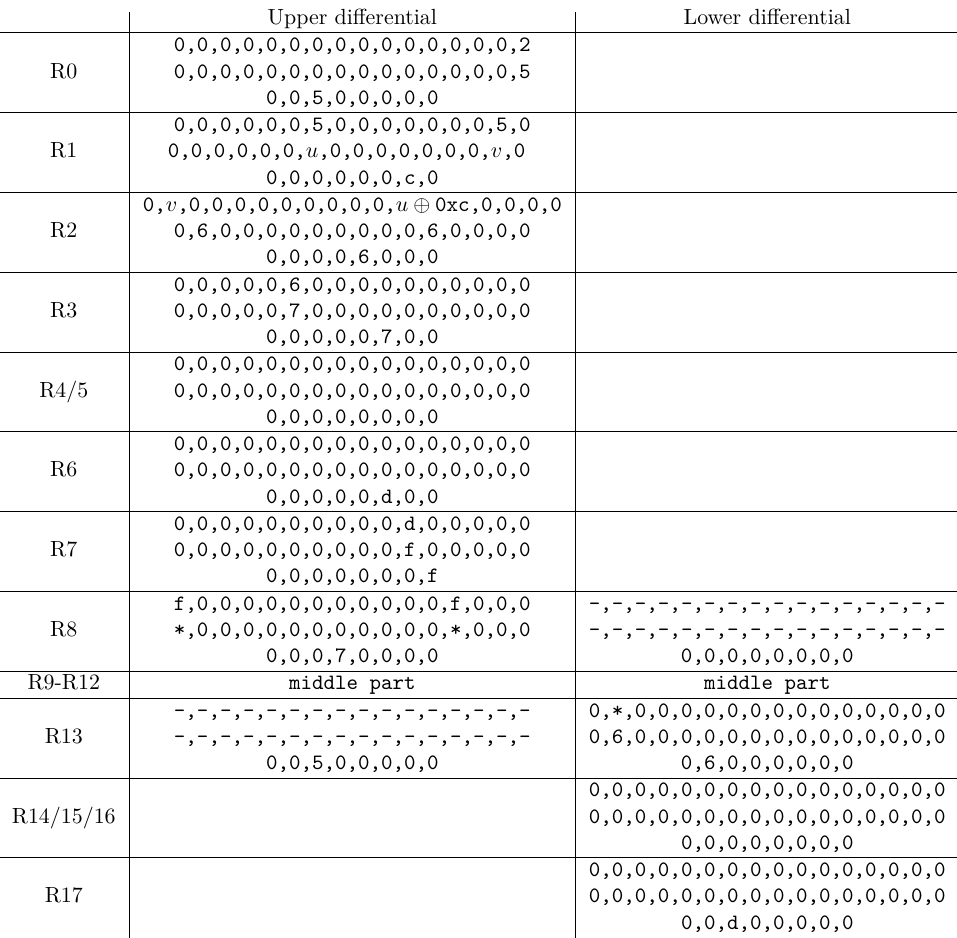
Table 16: The differentials of the 18-round distinguisher for Skinny-64-128 , where R8 to R13 is the r = 6-round middle part, u satisfies DDT[ 0x5 ][ u ] > 0 and DDT[ u ⊕ 0xc ][ 0x6 ] > m 0, v satisfies DDT[ 0x5 ][ v ] > 0 and DDT[ v ][ 0x6 ] >